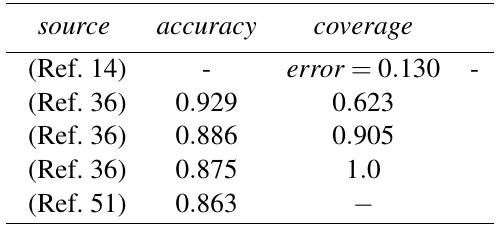
Table 1. Best results for Australian credit by some rough set based algorithms